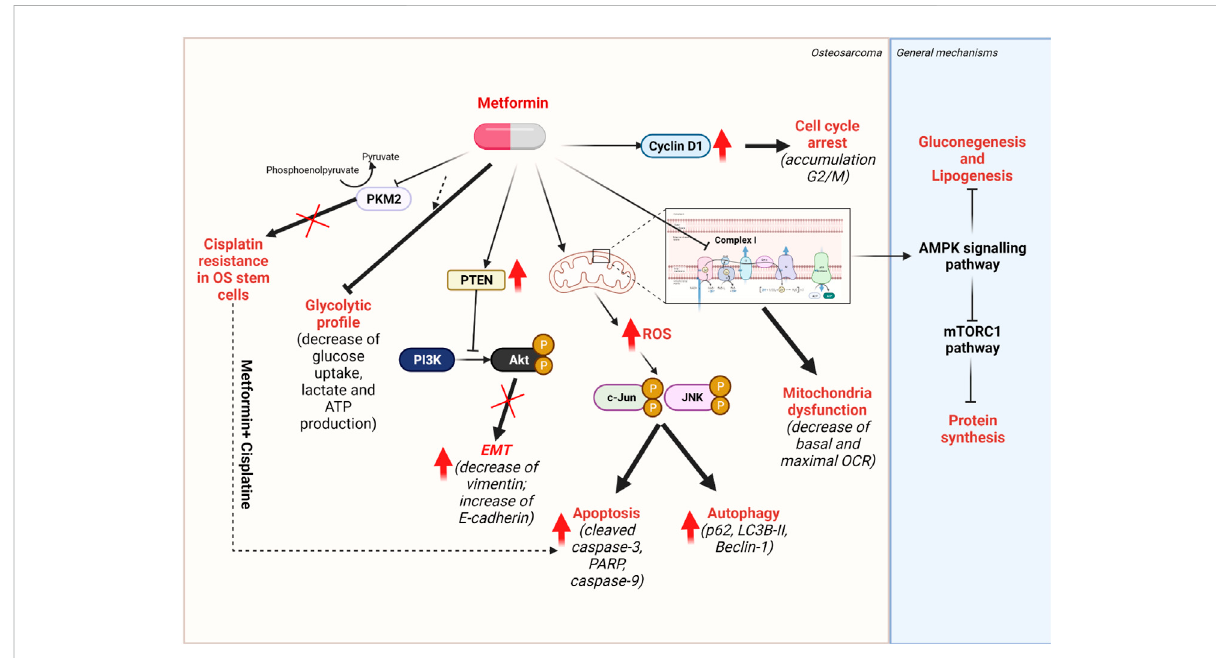
FIGURE 6 Mechanisms of action of metformin. Metformin targets mitochondrial complex I of respiratory chain, thus induces the activation of AMPK signalling pathway, resulting in the inhibition of glucogenesis and lipogenesis. The overactivation of AMPK pathway also inhibits the mTORC1 pathways, thus, protein